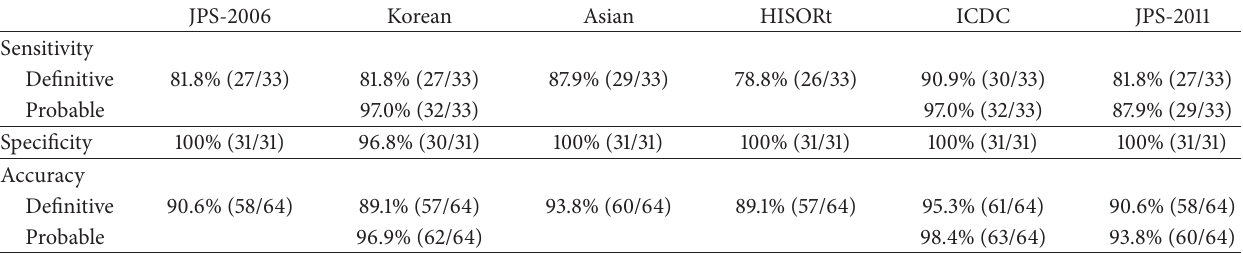
Table 5: Sensitivity, specificity, and accuracy of each diagnostic criteria system for indeterminate